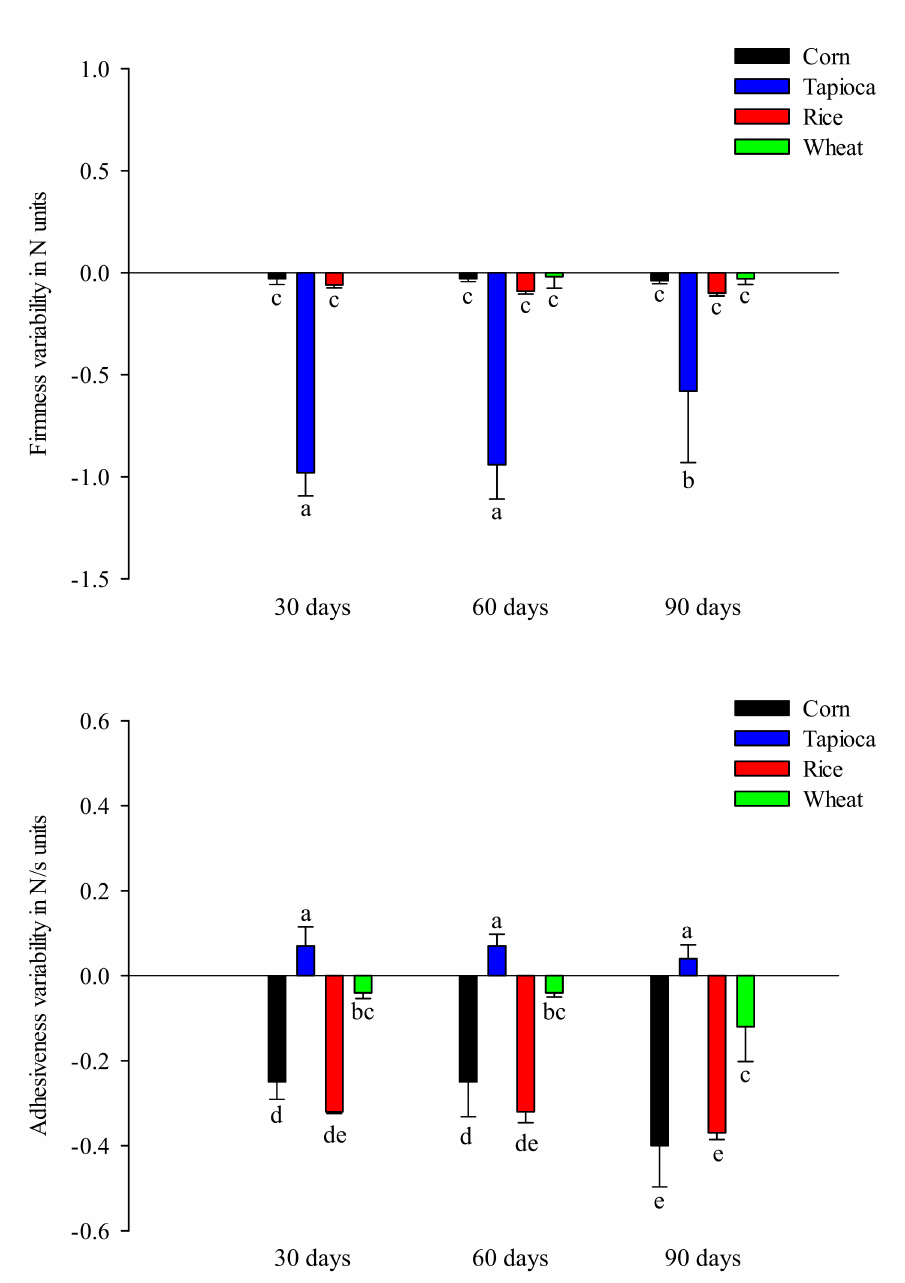
Figure 3. Influence of storage time on firmness and adhesiveness values of starch-based HPP hydrogels. Different letters above the bars indicate significant differences among the mean values (LSD, p ≤